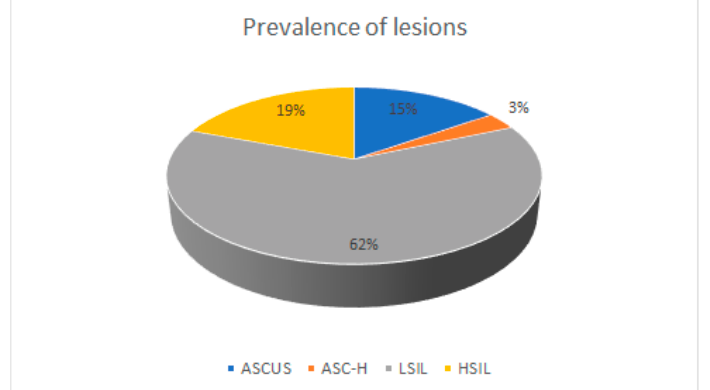
Figure 1. Prevalence of precancerous cervical lesions among the study participants. The prevalence of squamous lesions stratified by age groups is summarized in Table 2. The highest prevalence of ASCUS and ASCs-H (37%) was observed among older women aged between 38 and 51 years old. The youngest group of women in this study (20–30 years old) had the highest prevalence of LSIL (30%). Women aged between 31 and 37 years old had the highest prevalence of HSIL (33%). As the p -value obtained by the Pearson’s chi-square test is greater than the significance value (0.05), the relationship be- tween squamous lesions and age groups is not statistically significant. Table 2. Squamous lesions stratified by age groups and diseases.